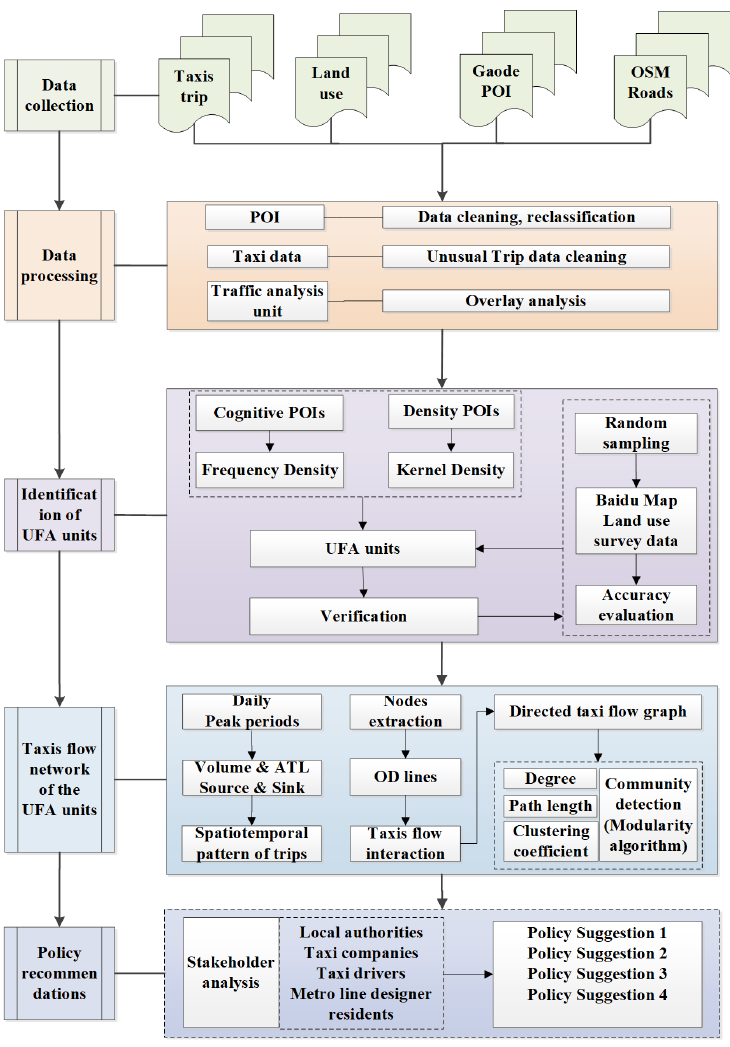
Figure 2. The data flow chart of the study.